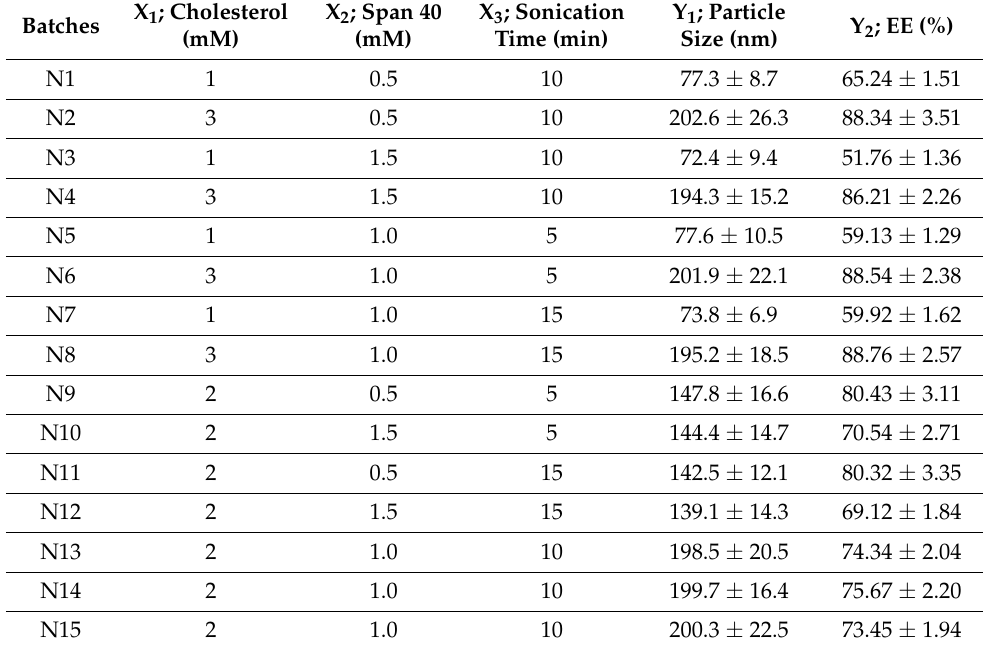
Table 1. Composition and parameters evaluated for Box-Behnken design batches. The data presented are average ± SD of different batches (n = 6).